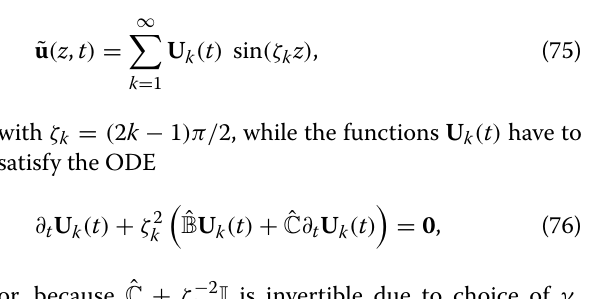
and the inhomogeneous initial condition